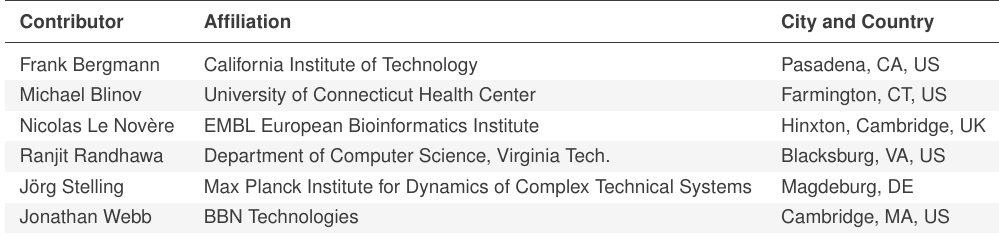
Table 1: Individuals who made significant contributions that influenced this Hierarchical Model Composition